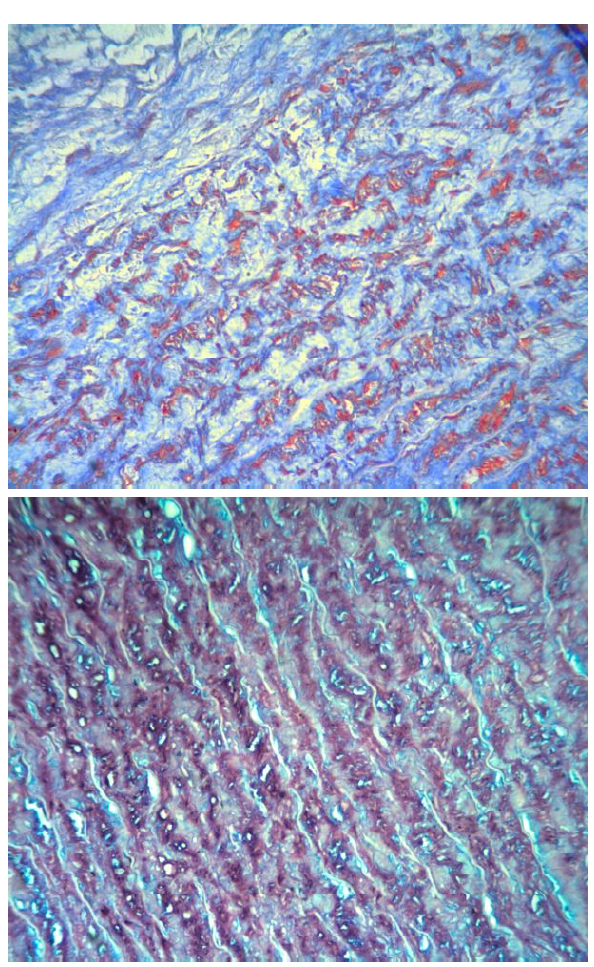
Fig. 4 – Histology of the ascending aorta of a 44-year-old female patient with acute type A aortic dissection, showing (A) retained aortic wall structures with more collagens and cystic-like lesions. Masson×200; and (B) Small focal cystic-like lesions with acid mucopolysaccharides accumulation in the retained aortic media indicating a Grade 2-3 cystic medial necrosis. AB-PAS×200